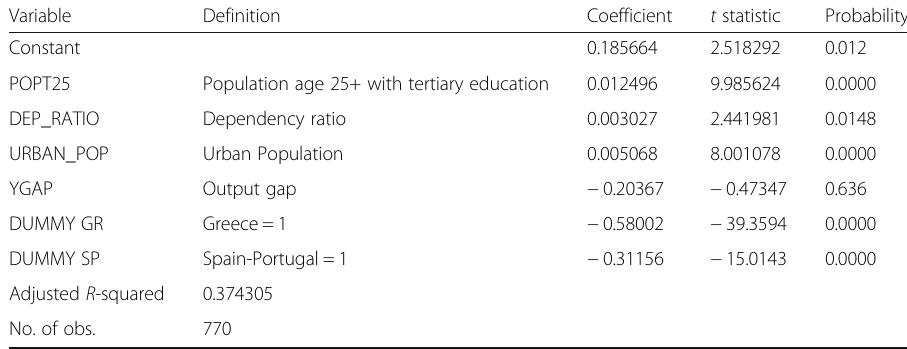
Table 6 TSL vs demographic factors and the state of the business cycle variables with country dummies